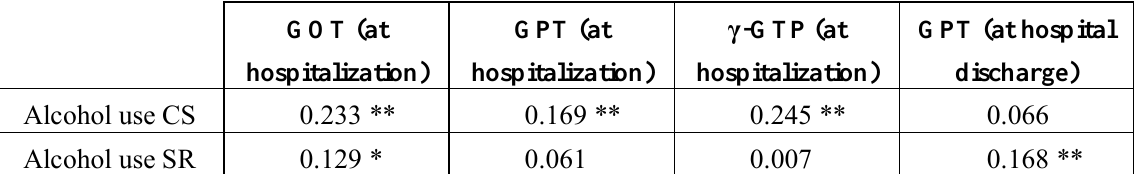
Table 6. Correlation coefficients between the Alcohol use CS and biological markers ( n =